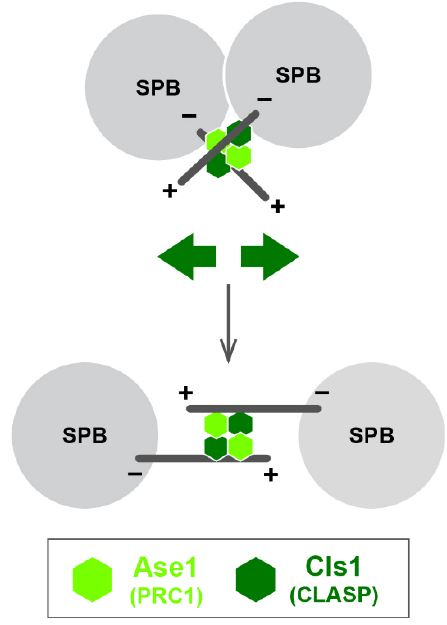
Figure 4. Outward force generation through the spindle midzone. Short microtubules nucleating from the two SPBs are crosslinked in an antiparallel manner and stabilised by Ase1/PRC1 and Cls1/Peg1/CLASP. This provides an outward force (green arrows) towards the SPB that is sufficient to form short bipolar spindles in the absence of Kinesin-5 and Kinesin-14 [64]. + and – stand for the microtubule plus and minus ends, respectively.